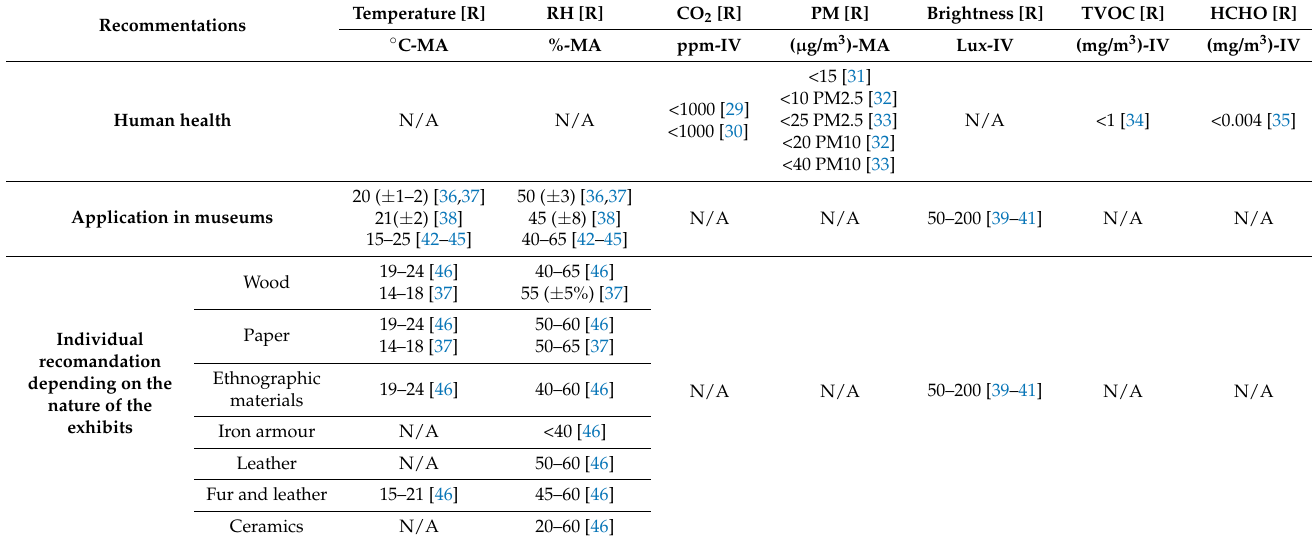
Table 1. International standards in terms of indicators analysed, both for human health and for the integrity of exhibits.